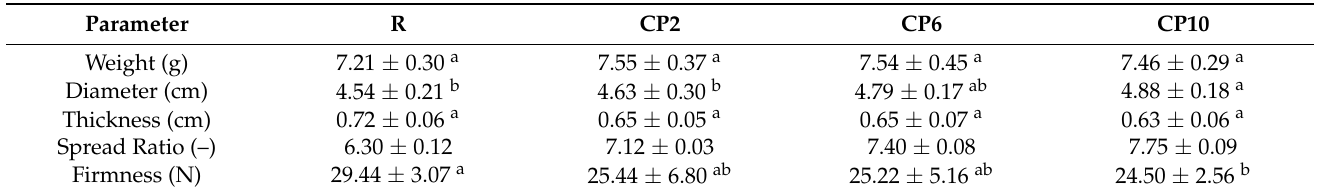
Table 6. Physical properties of